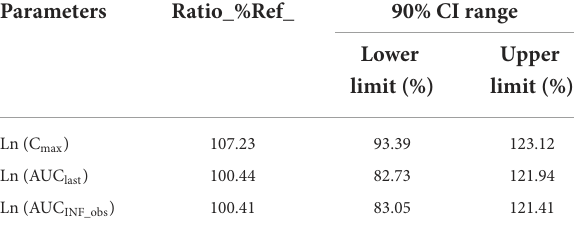
TABLE 3 BE analysis of cyclosporine test and reference